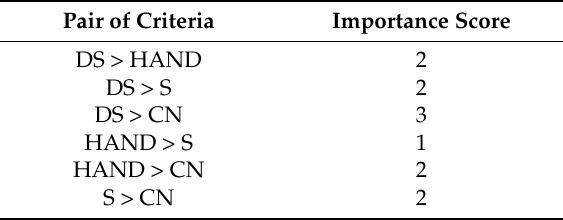
Table 7. Assigning the importance score. S: slope.